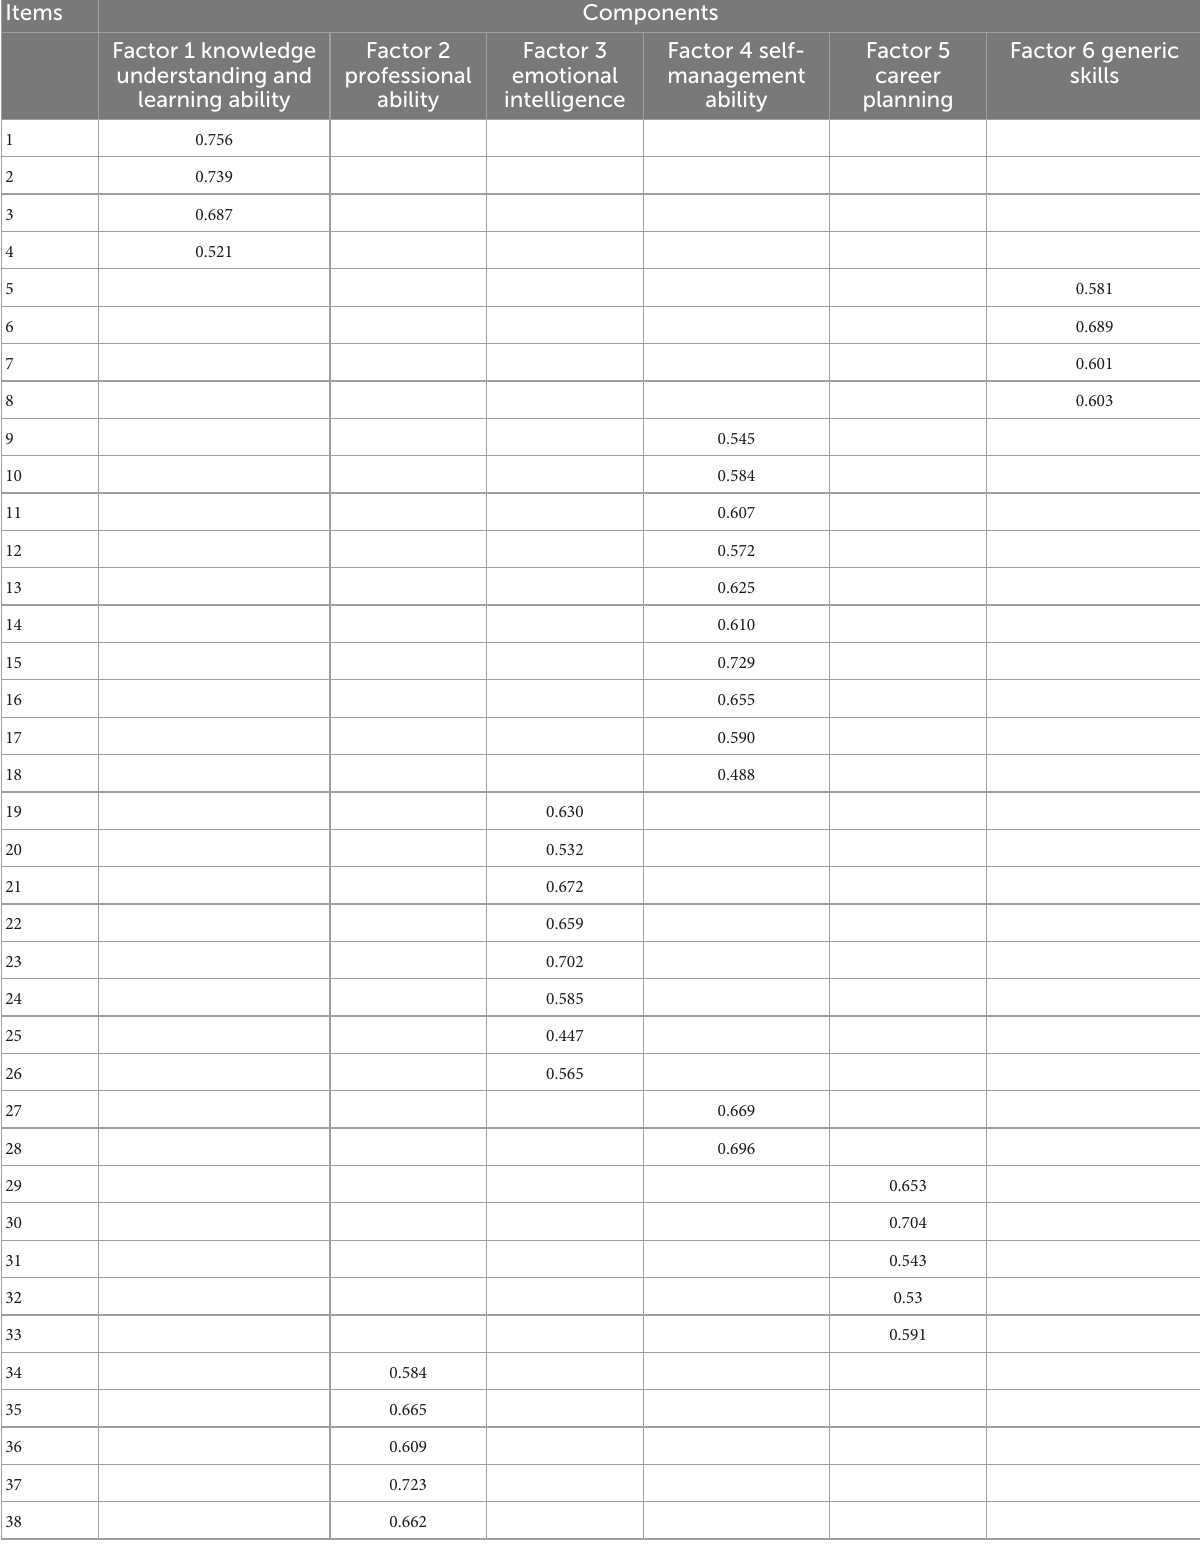
TABLE 7 Rotated component